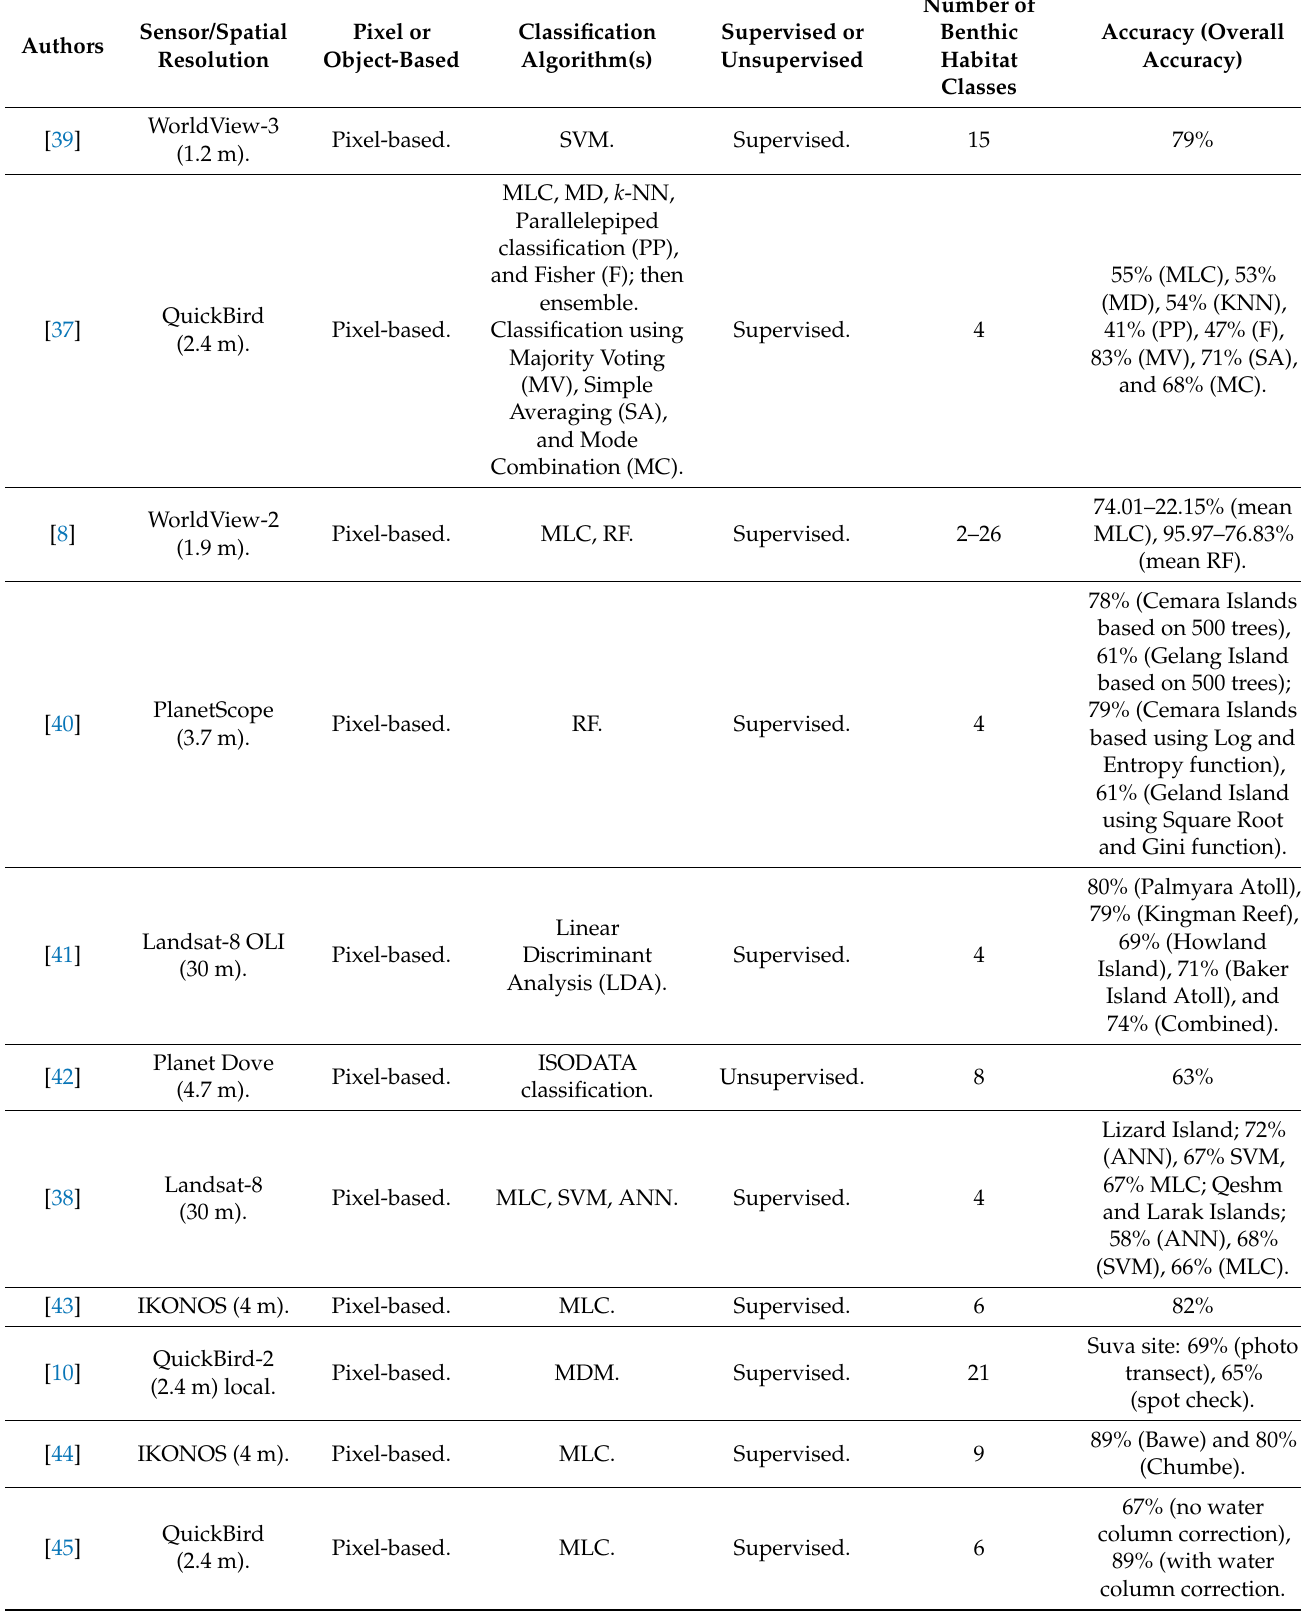
Table 1. Pixel-based coral reef benthic mapping